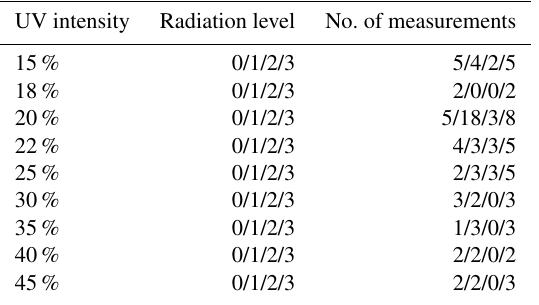
Table 2. The range of UV and radiation level settings that were used through the measurement series. The radiation levels are 0: N = 19000cm − 3 . The last column shows the number of measurements at each setting. The reference measurements were performed at 20% UV and radiation level